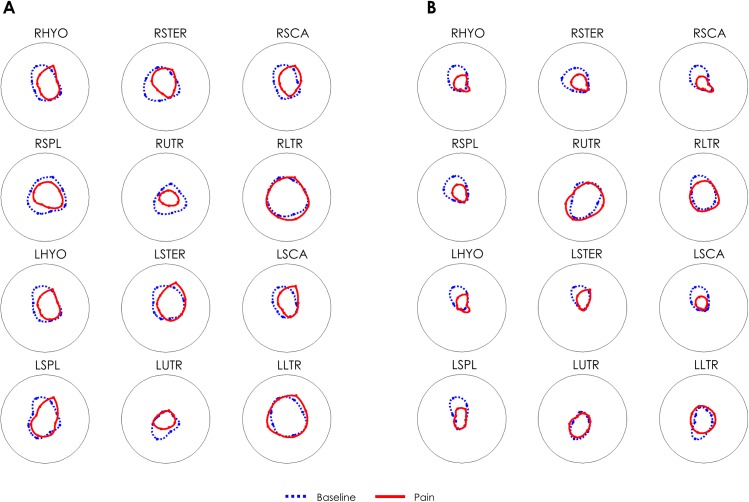
Representative EMG amplitude data from two subjects (A and B respectively).Each line represents the integrated EMG activity for each movement direction, and data is interpolated between directions for representation. Data is normalized with respect to the maximal value between BASE and PAIN for each muscle. Note the consistent decreased activity for the injected muscle (right splenius capitis) for both subjects but the variable change for the other muscles. For instance, the right upper trapezius (RUTR) shows reduced activity in the painful condition for Subject A but increased activity for subject B. (Right–R and Left–L: Sterno Hyoideus–HYO, Sternocleidomastoideus-STER, Anterior Scalenus-SCA, Splenius Capitis–SPL, Upper trapezius-UTR, Lower Trapezius-LTR).